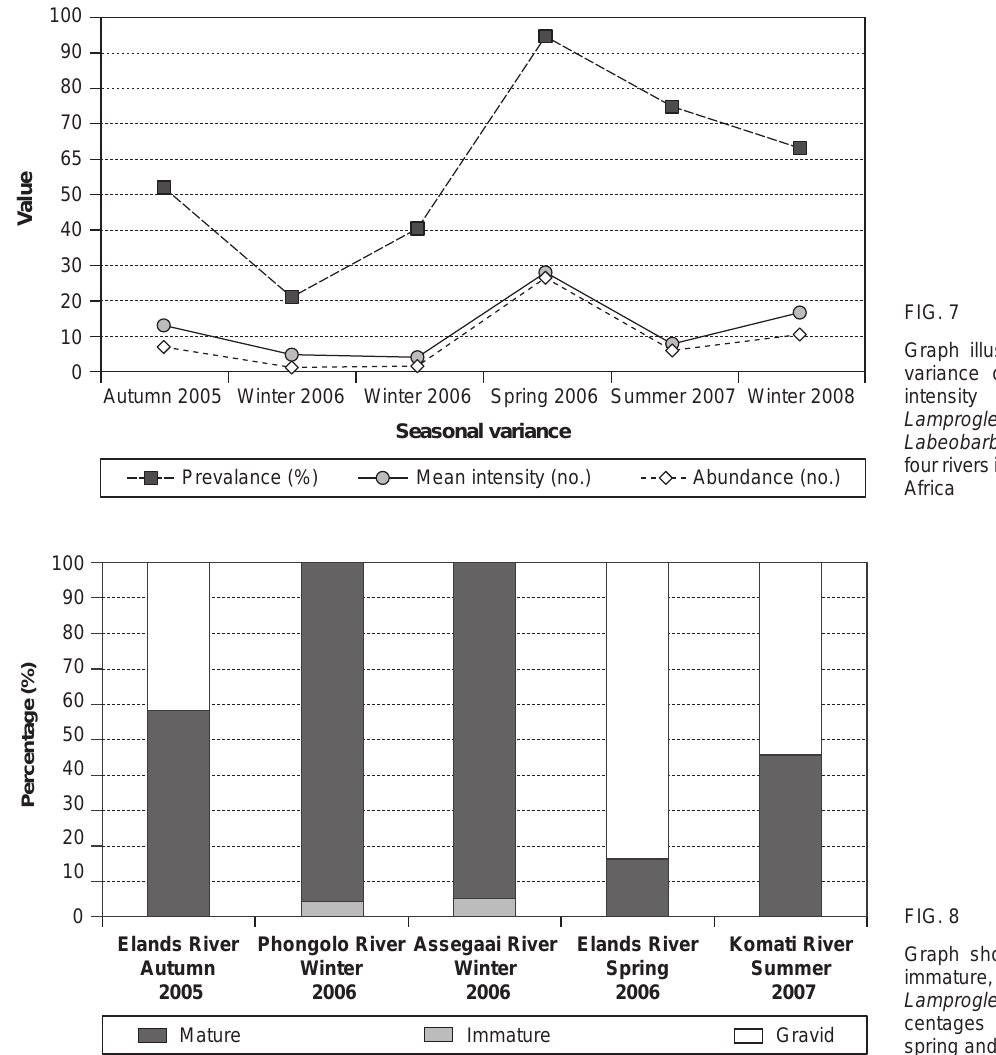
Graph showing composition of immature, mature and gravid Lamproglena hoi females per- centages in autumn, winter, spring and